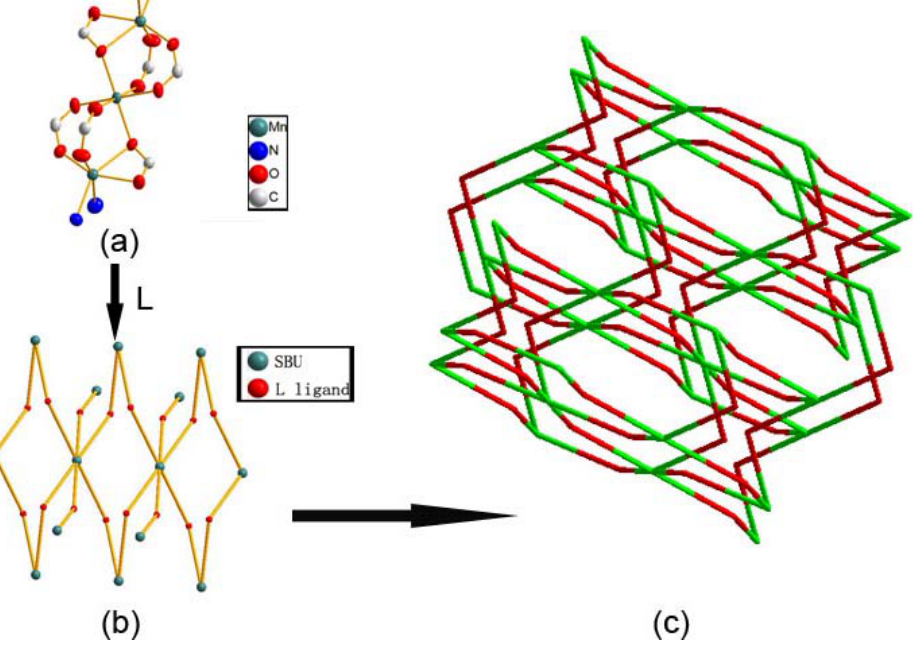
Figure 4. View of the big cavity in the 3-D coordination